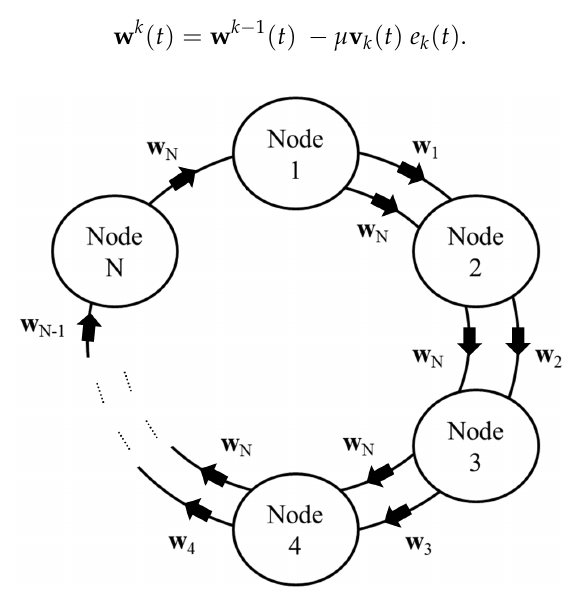
Figure 4. Ring network with incremental